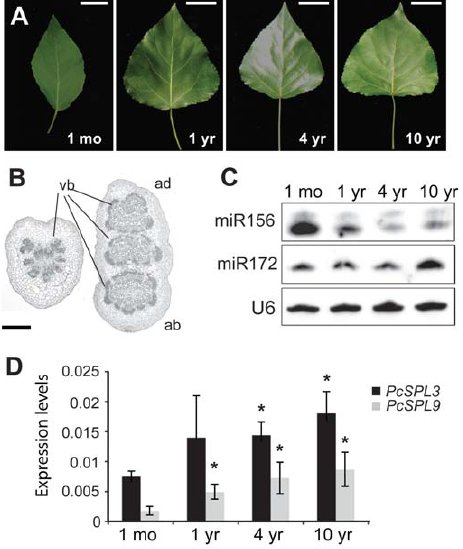
Figure 2. Vegetative phase change and miRNA expression in P. xcanadensis . (A) Leaf morphology. Scale bars indicate 2 cm for 1- month-old trees and 4 cm for the rest. (B) Transverse sections of petioles of 1-month- (left) and 1-year-old (right) trees. ab, abaxial. ad, adaxial. vb=vascular bundles. Scale bar indicates 200 m m. (C) Expres- sion of miR156 and miR172, with U6 as loading control. (D) Expression of PcSPL3 and PcSPL9 , measured by real-time RT-PCR, and normalized to PcACT . Error bars indicate standard deviation (s.d.). Asterix=significantly different from 1-month-old saplings, p , 0.01, Student’s t test.